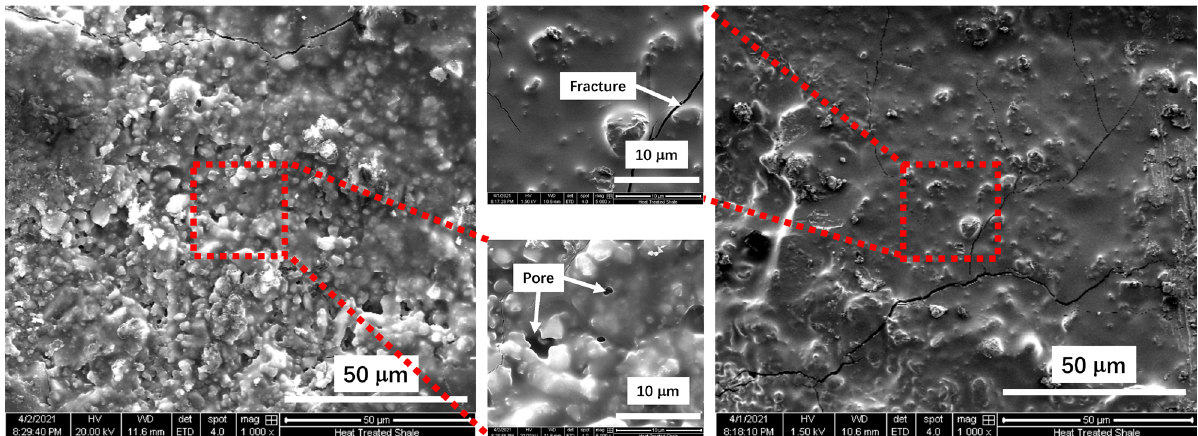
Figure 2. SEM images of the pores and fractures within the shale sample after thermal exposure.